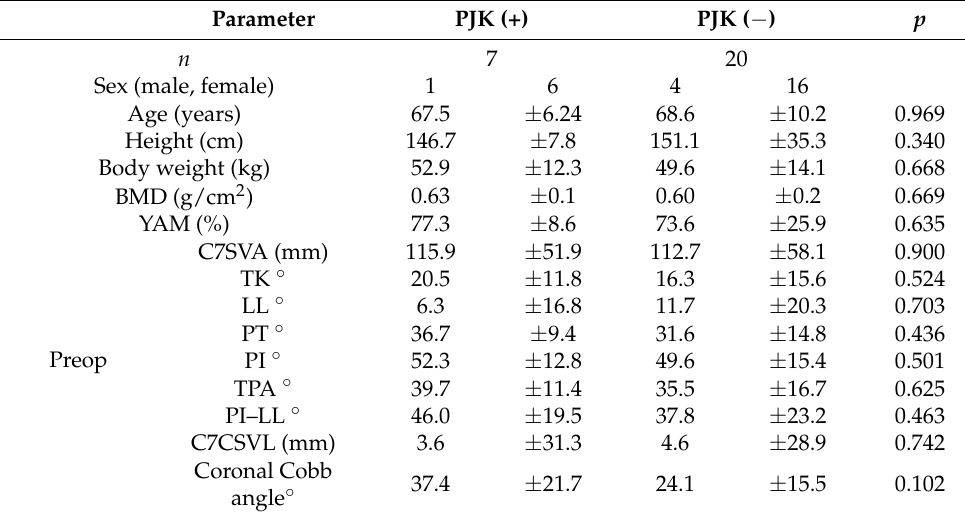
Table 2. Patient demographics.